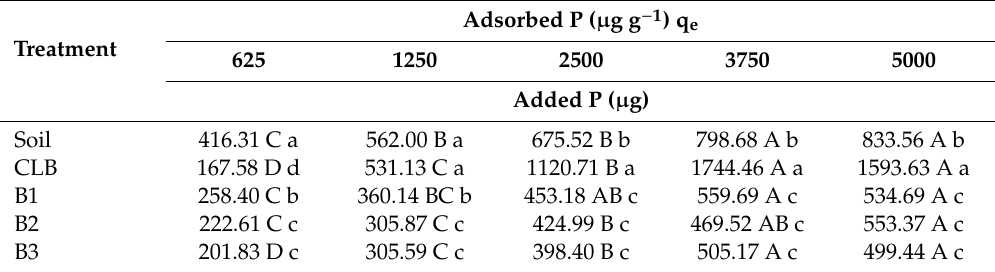
Table 9. Phosphorus addition to phosphorus adsorption based on di ff erent treatments.